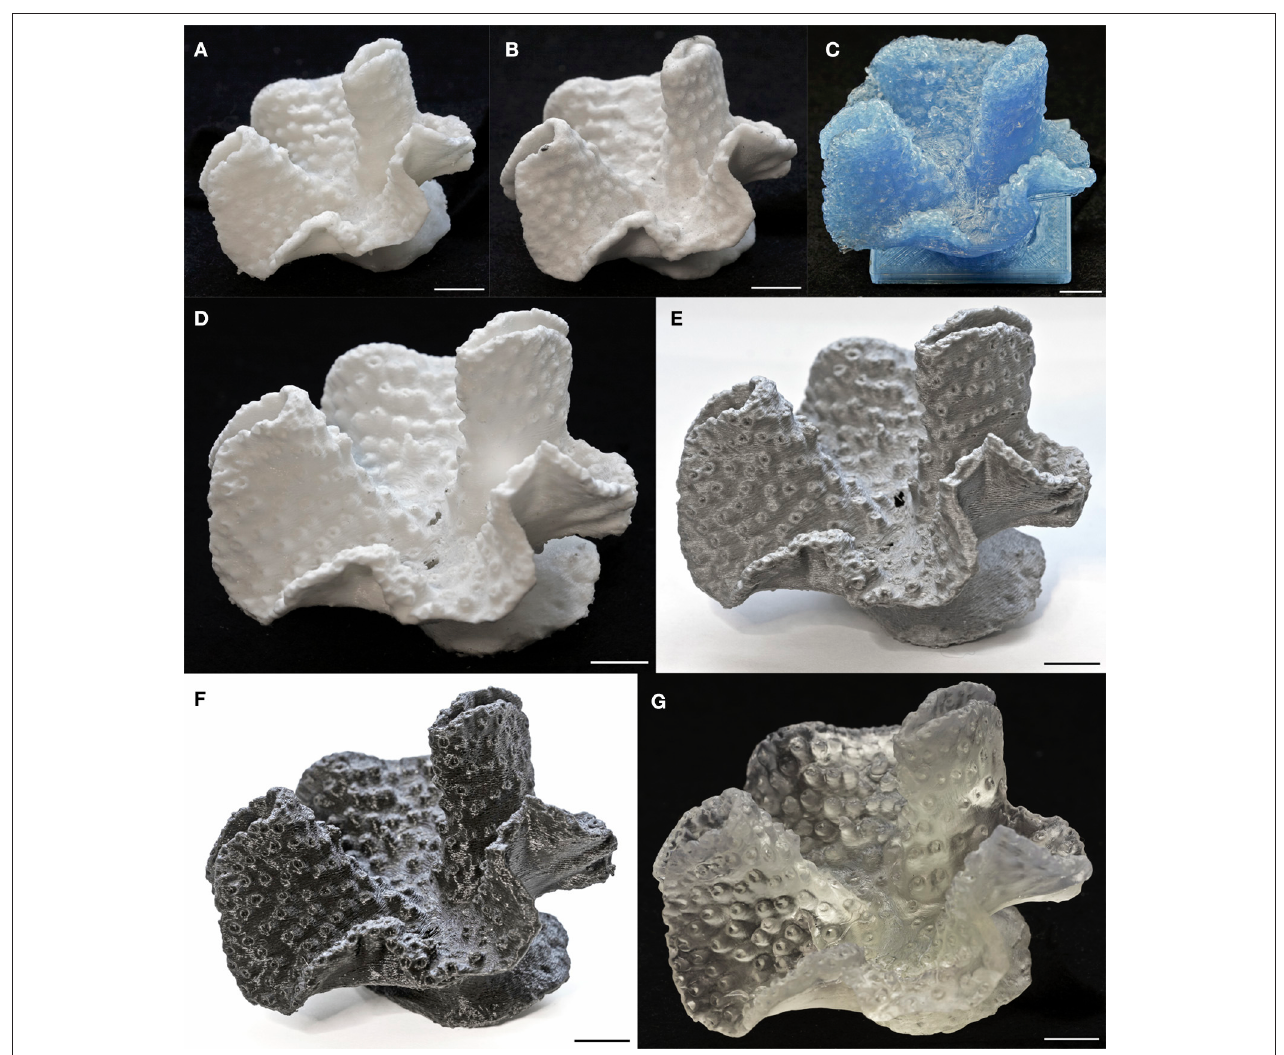
FIGURE 6 | Multi-material 3D printing of Turbinaria sp. colony. (A) White ABS print of colony. (B) Sandstone print of colony. (C) Blue PLA print of colony. (D) White PLA print of corallites. (E) Silver PLA print of colony. (F) Black PLA print of colony. (G) Translucent resin print of colony. Scale bar represents